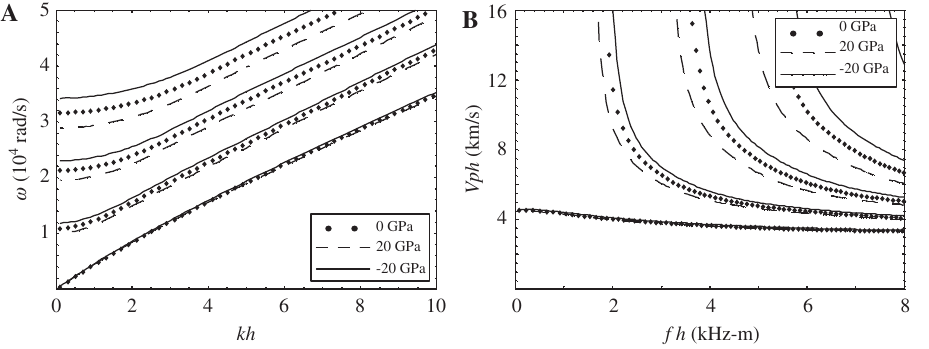
Figure 8 Circumferential SH wave dispersion curves for the sinusoidally graded cylindrical plate with η = 2 under different radial initial stresses: (A) frequency spectra, (B) phase velocity spectra.